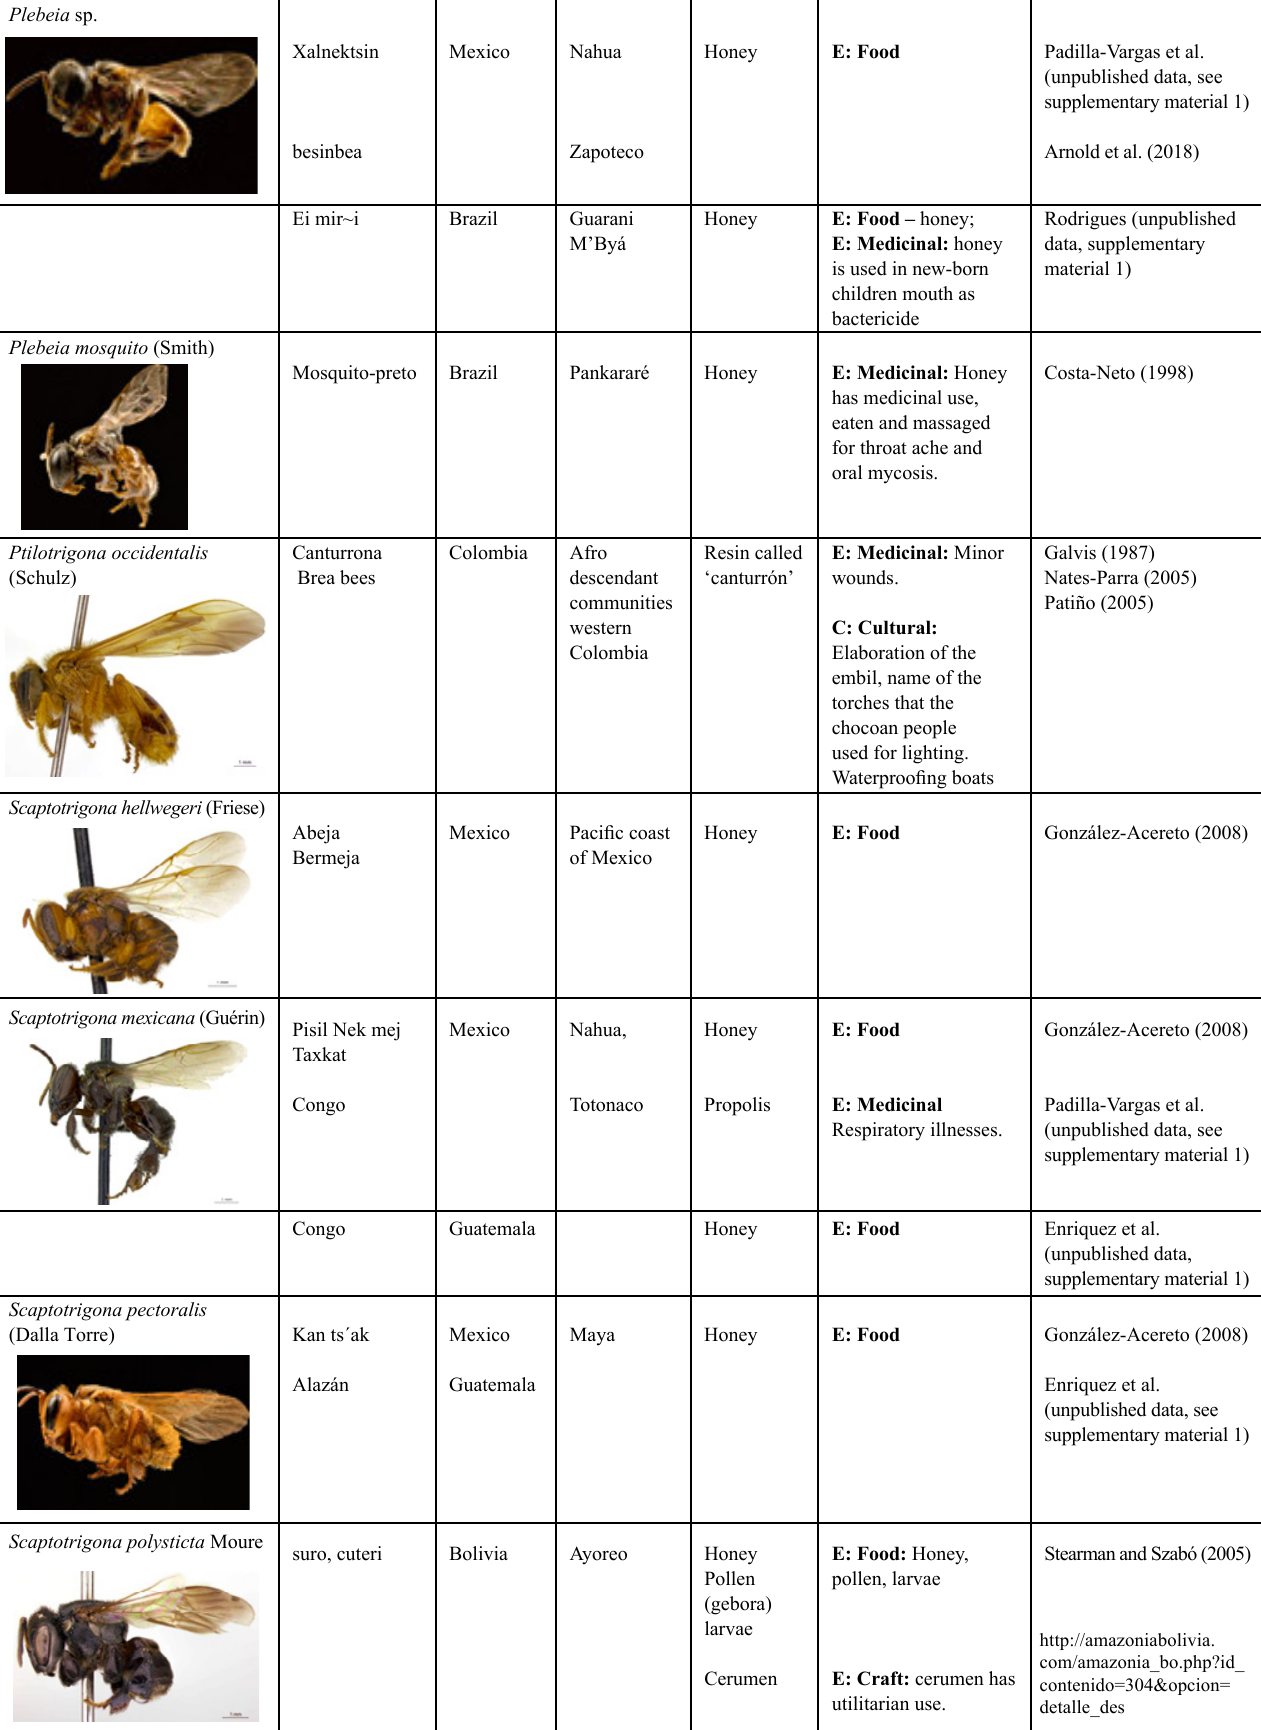
Table 1 . Economic and cultural values associated with stingless bees by different ethnic groups of tropical America.